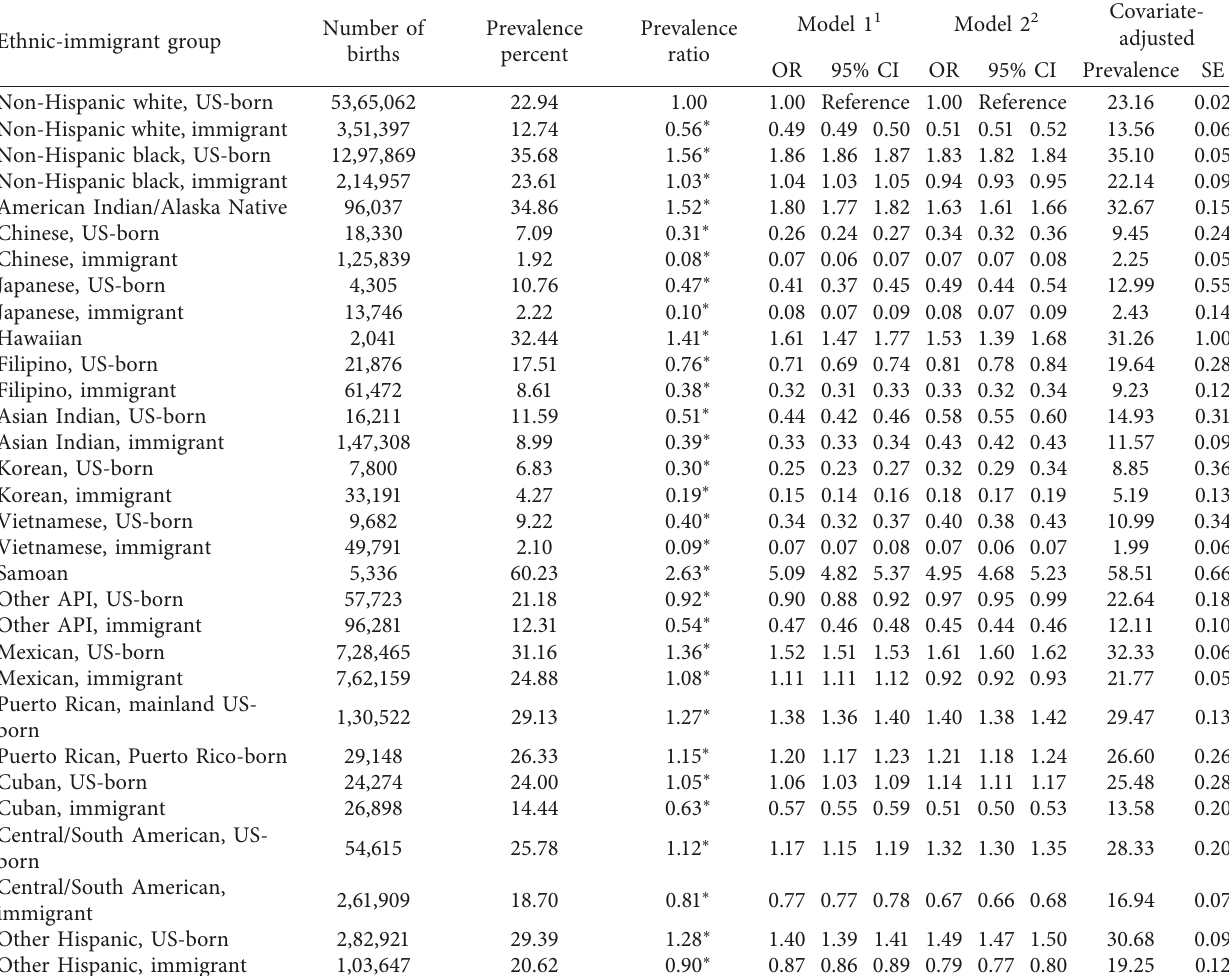
Table 4: Observed prevalence and adjusted odds and prevalence of pre-pregnancy obesity (BMI ≥ 30) among women in 31 ethnic-immigrant groups, United States, 2012–2014 ( N � 10 , 431 ,